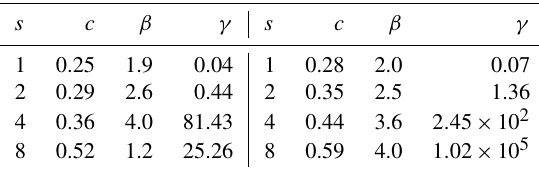
Table 1. Fit parameters of the first passage time distribution (see Eq. (4)) to the empirical first passage times of the tracers in the northern (left) and southern (right) hemisphere. Notice that the es- sential parameter H has not been fitted but is given by the scaling of the MSD. Numerical fitting was performed by the nonlinear least squares